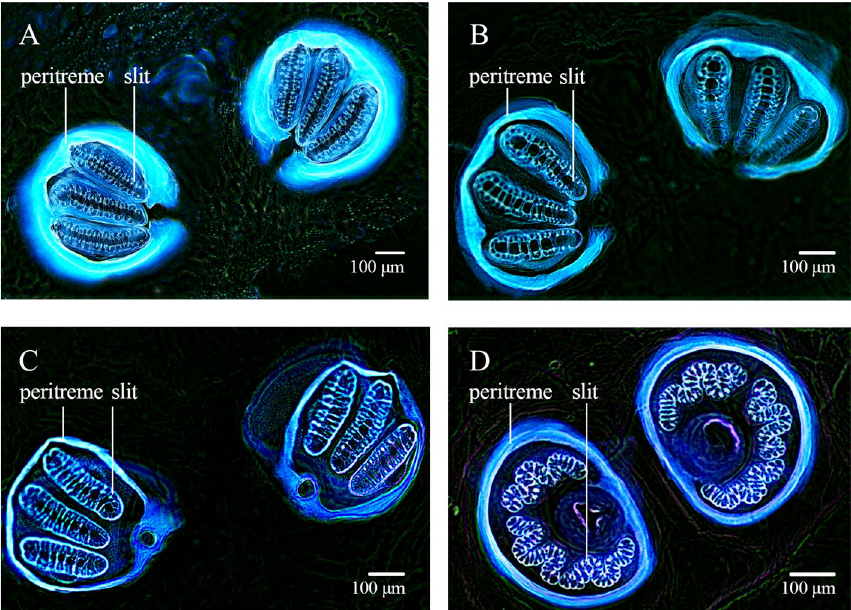
Figure 2. Morphology of posterior spiracles of four different fly species after inverting the image colors; ( A ) Chrysomya ( Achoetandrus ) ruffifacies , ( B ) Chrysomya megacephala , ( C ) Lucilia cuprina , ( D ) Musca domestica .